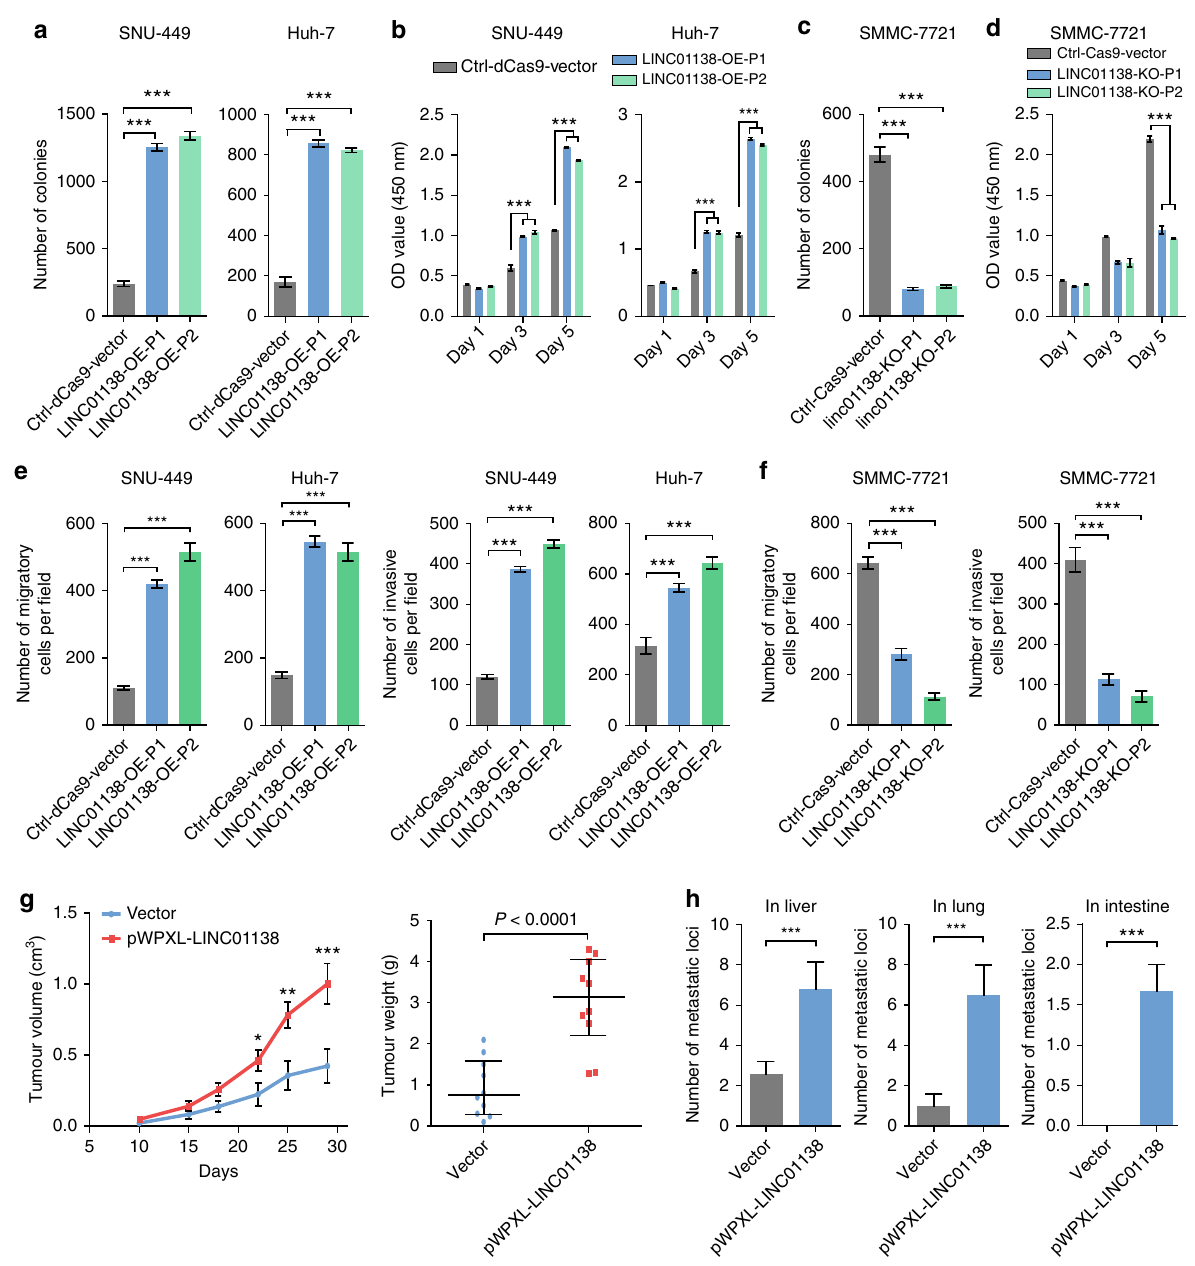
Fig. 2 LINC01138 increases HCC cell proliferation, invasion and metastasis in vitro and in vivo. a , b Colony formation assays ( a ) and CCK-8 assays ( b ) in the SNU-449 and Huh-7 cells with LINC01138 activation by the CRISPR/dead-Cas9 technology. c , d Colony formation assays ( c ) and CCK-8 assays ( d ) in the SMMC-7721 cells with LINC01138 knockout by the CRISPR/Cas9 technology. e Transwell migration and invasion assays in the SNU-449 and Huh-7 cells with LINC01138 activation by the CRISPR/dead-Cas9 technology. f Transwell migration and invasion assays in the SMMC-7721 cells with LINC01138 knockout by the CRISPR/Cas9 technology. g Tumour volumes and tumour weights were measured in the pWPXL-LINC01138 and negative control groups in the xenograft mouse models. h Statistics analysis of the metastatic foci in the liver, lung and intestine obtained from nude mice at 9 weeks after injection with the stable pWPXL-LINC01138 SMMC-7721 cells detected by haematoxylin-eosin staining. The stably cells established via the CRISPR/Cas9 knockout and CRISPR/dead-Cas9 activation technology was nominated as KO and OE, respectively. Two paired sgRNAs were identi fi ed to be effective in both knockout system and activation system, nominated as P1 and P2, respectively. Values are expressed as the mean ± SEM, n = 3 in b – f , n = 10 in g , h . *** P <